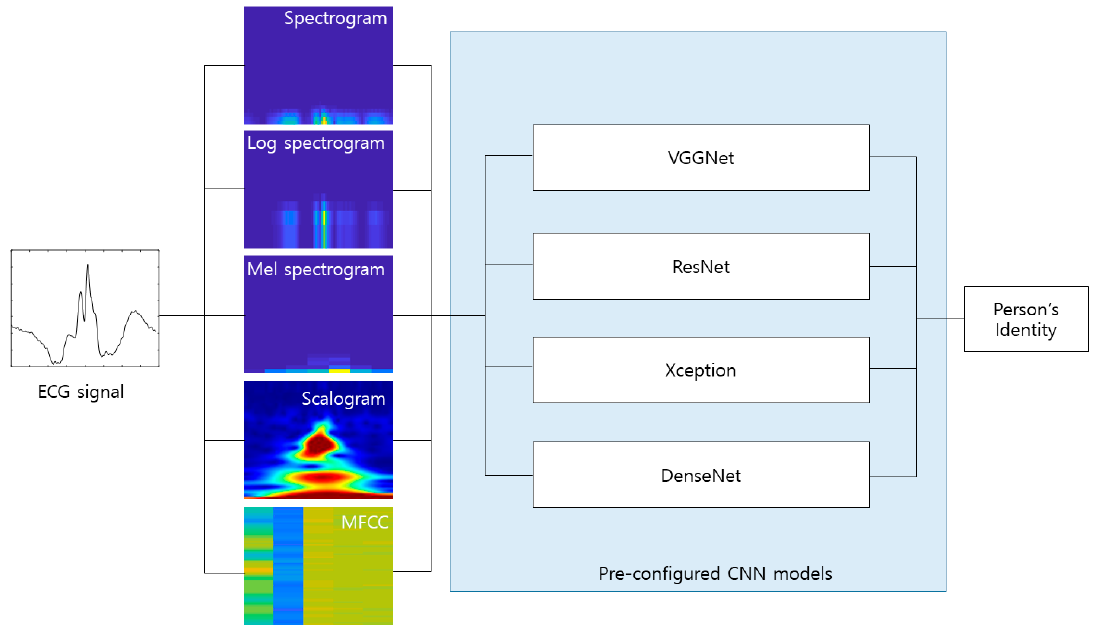
Figure 8. ECG biometrics using several time-frequency representations.